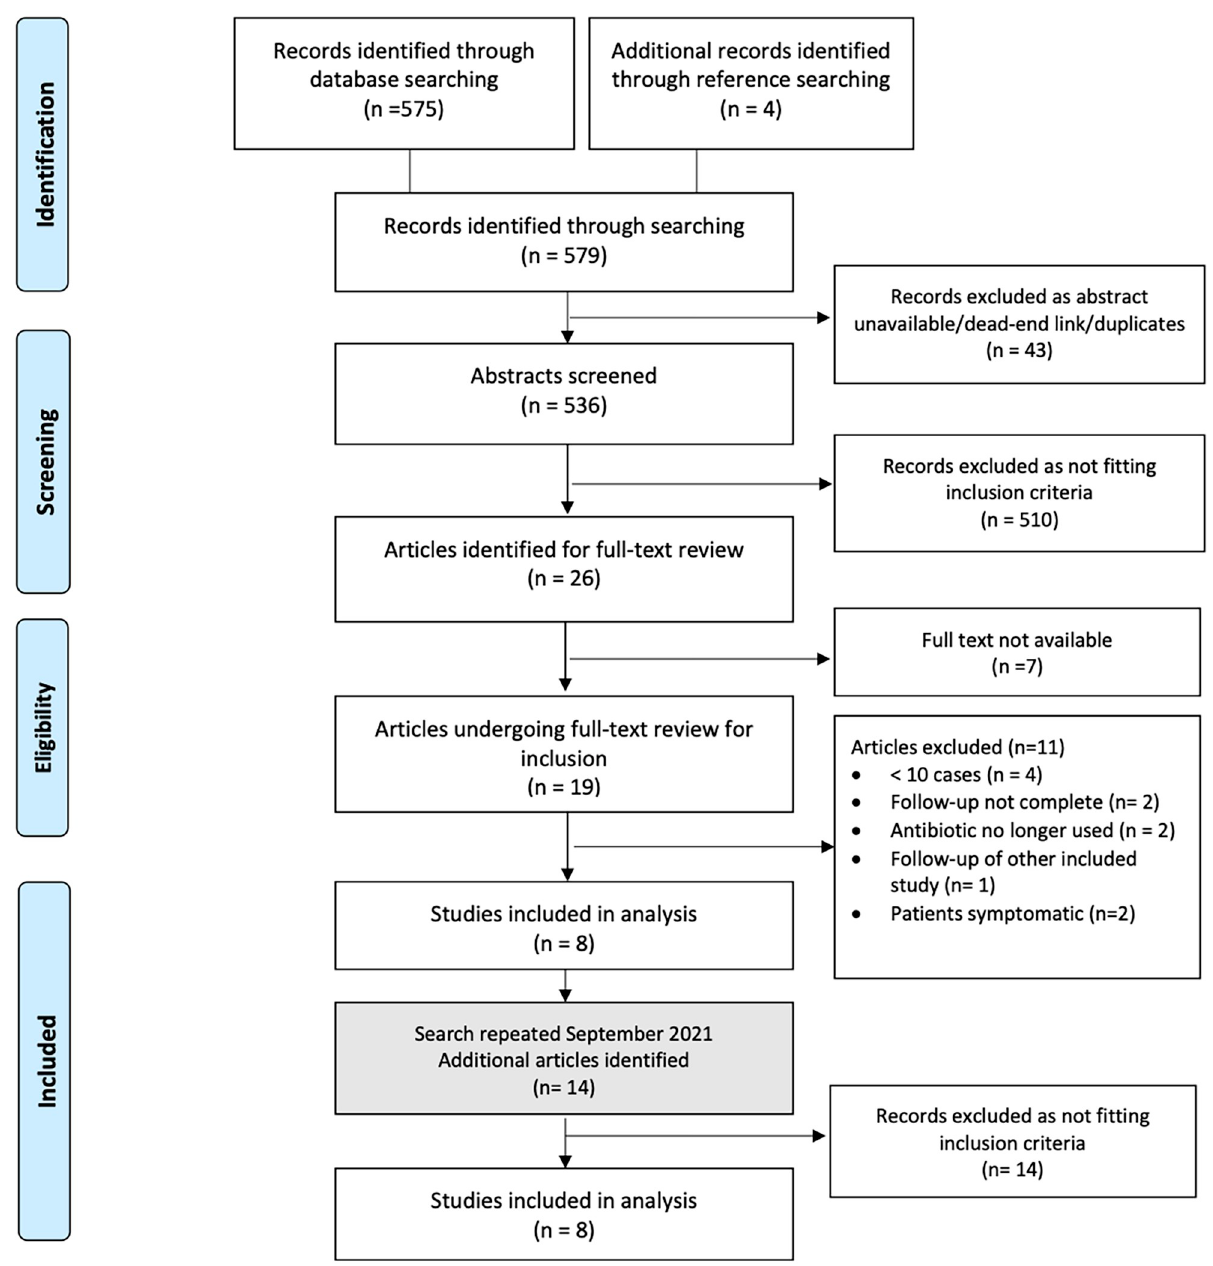
Fig 1. Preferred Reporting Items for Systematic Reviews (PRISMA) flow diagram of the study selection process. From : Moher D, Liberati A, Tetzlaff J, Altman DG, The PRISMA Group (2009). P referred R eporting I tems for S ystematic Reviews and M eta- A nalyses: The PRISMA Statement. PLoS Med 6(7): e1000097. doi:10.1371/joumal.pmed1000097 For more information, visit